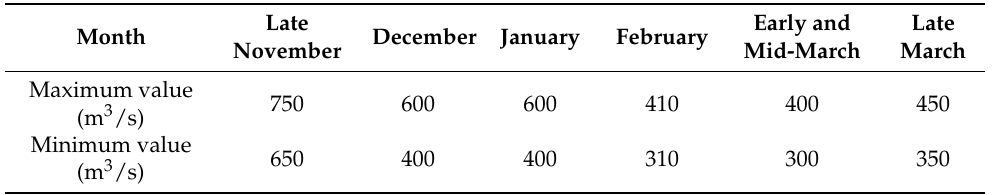
Table 4. Ecological basic flow in the lower reaches of the Liujiaxia Reservoir.